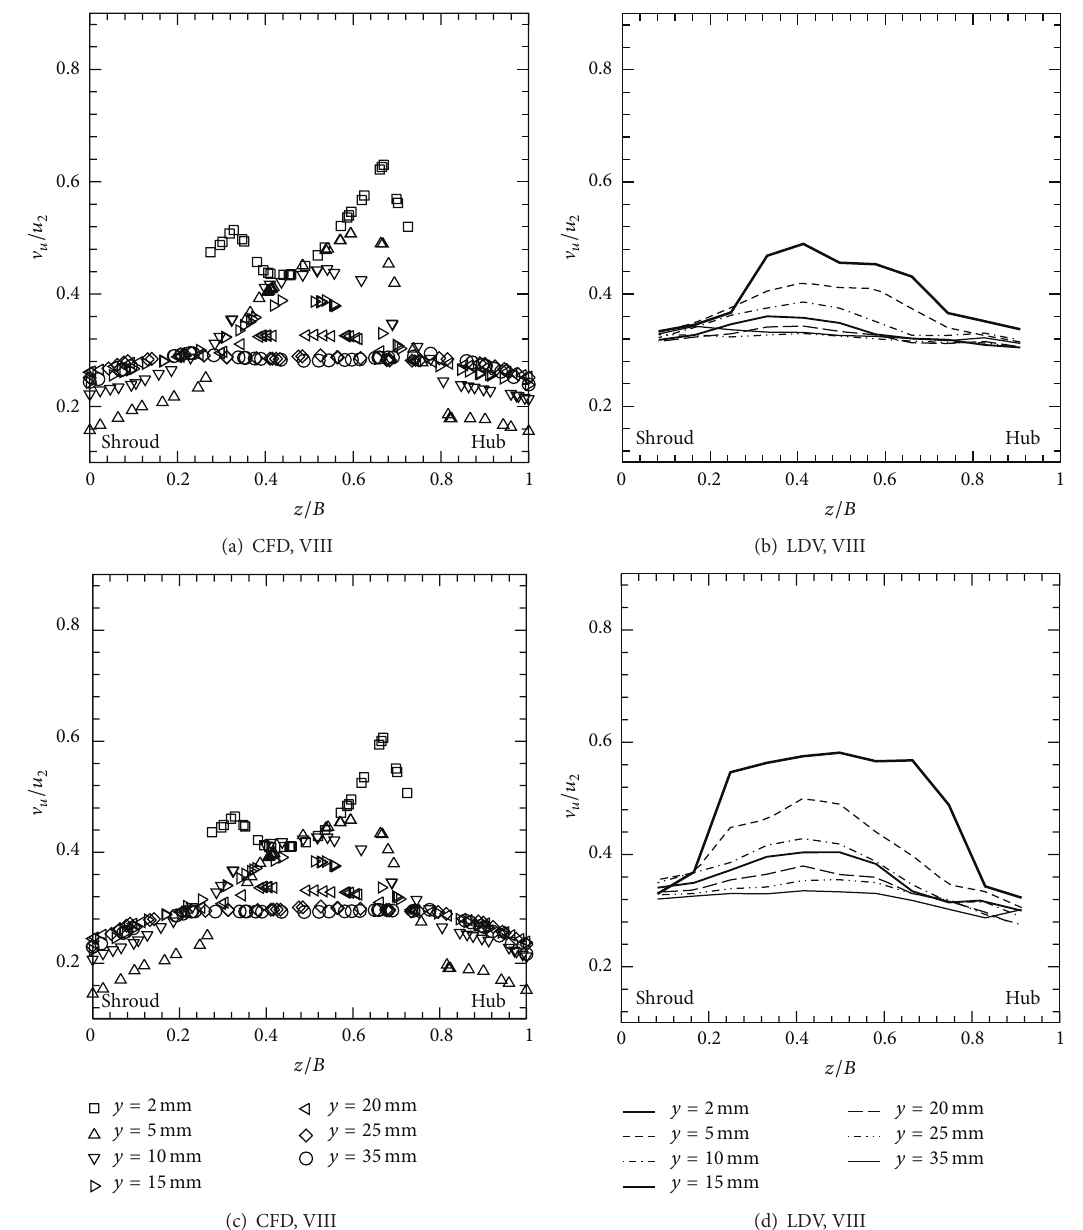
Figure 5: Measured and predicted circumferential velocity of fluid in volute throat at BEP and Ra = 50 𝜇 m for water (1cSt) and oil (48cSt), (a) CFD, water, (b) LDV, water, (c) CFD, oil, and (d) LDV,